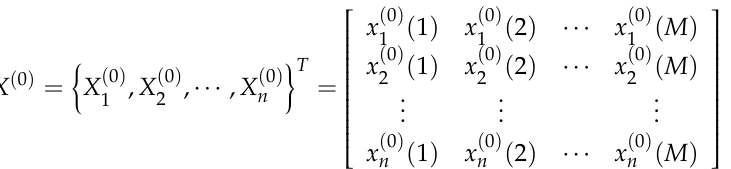
Table 6. Comparison table of the three prediction results.